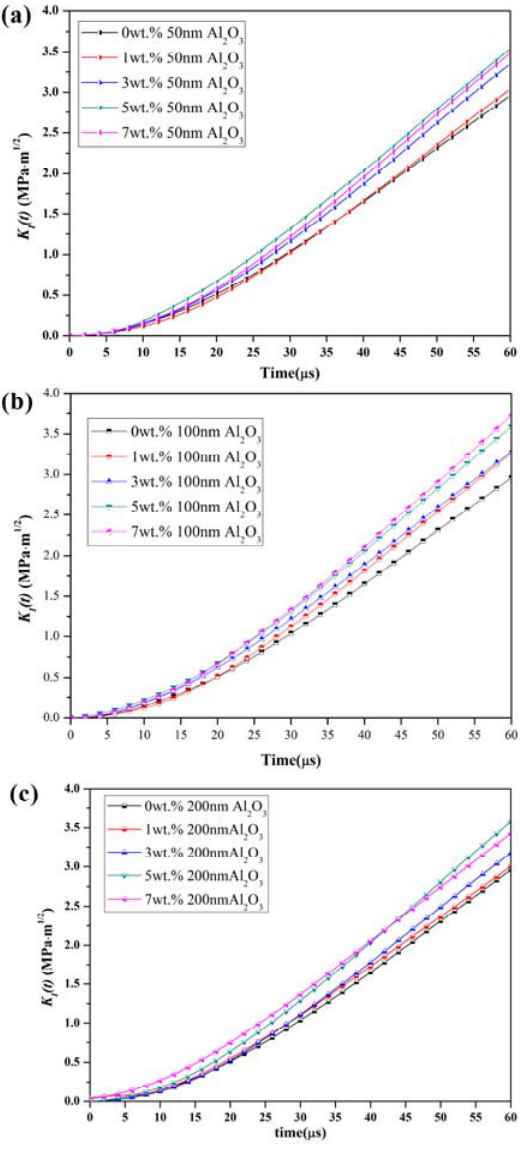
Figure 11. Dynamic stress intensity factor (DSIF) history of composites with different particle size and content: ( a ) epoxy resin modified with 50 nm particles; ( b ) epoxy resin modified with 100 nm particles; ( c ) epoxy resin modified with 200 nm particles.